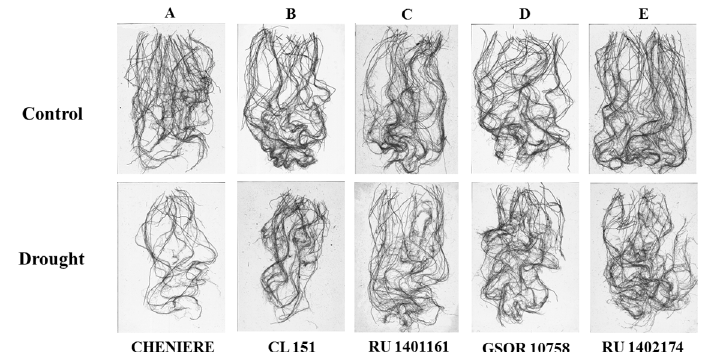
Figure 3. Representative scanned root images from control and drought sets in each drought stress response classes, ( A ) highly sensitive, ( B ) sensitive, ( C ) moderately sensitive, ( D ) tolerant, and ( E ) highly tolerant groups.